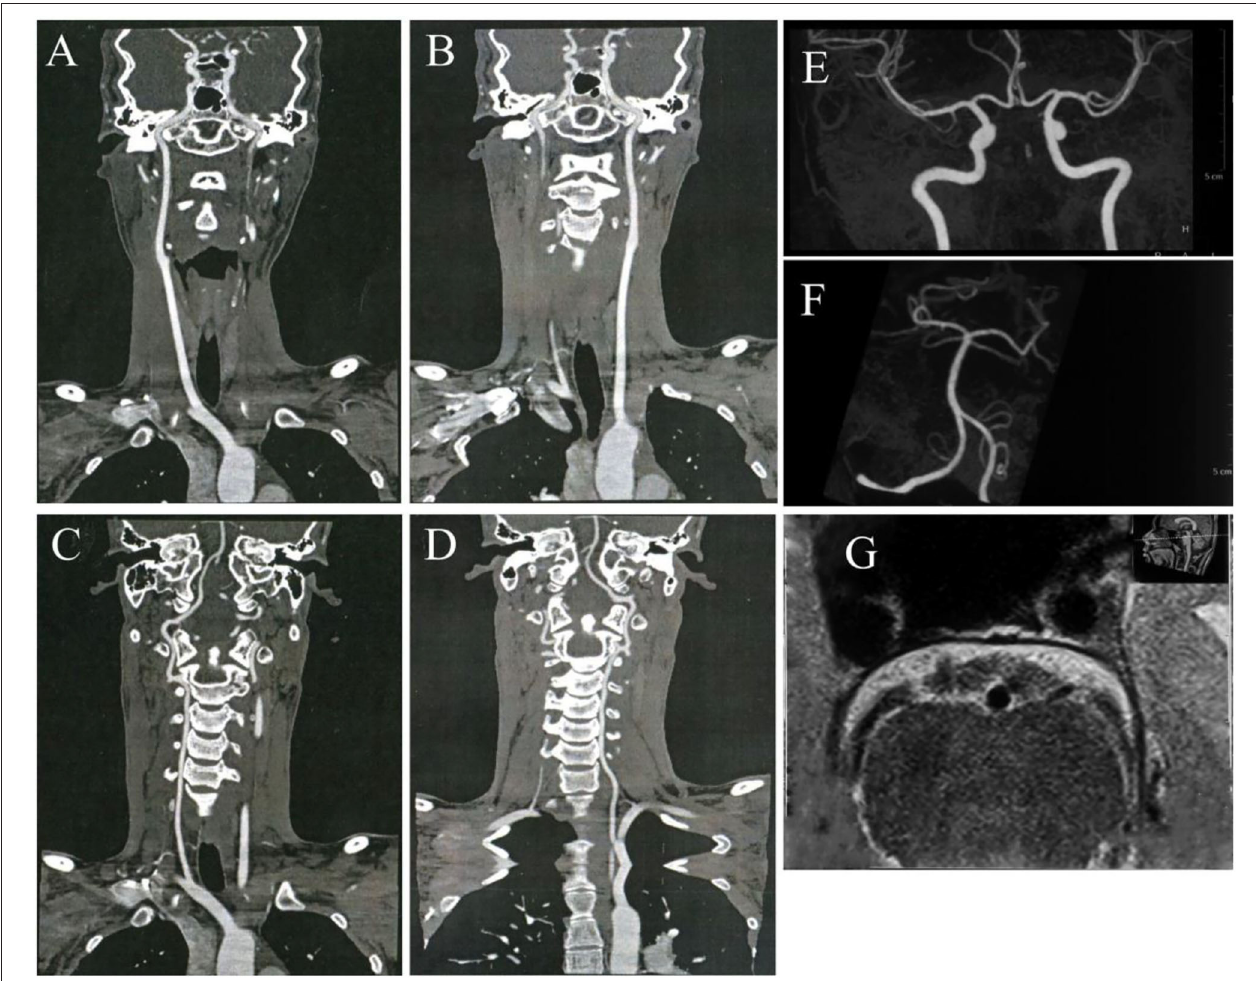
FIGURE 1 | No arterial occlusion, stenosis, or plaque was discovered in bilateral carotid arteries (A,B) , vertebral arteries (C,D) , and all the intracranial arteries (E,F) . The high-resolution vessel wall magnetic resonance imaging (MRI) of the basilar artery shows no occlusion or stenosis (G)